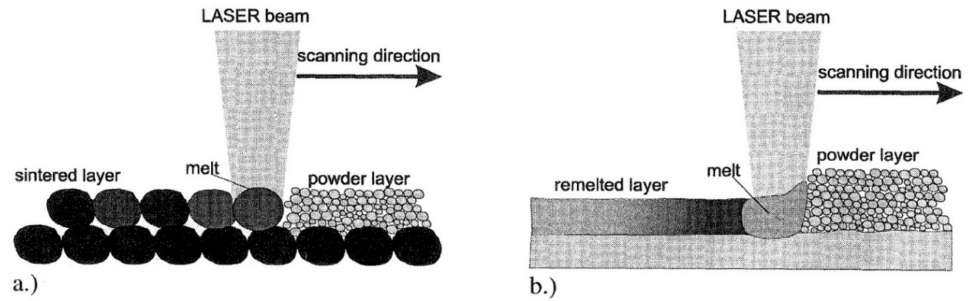
Figure 1. Melting process of single component powder with a laser beam: ( a ) porous structure with SLS and ( b ) dense structure with SLM [22].